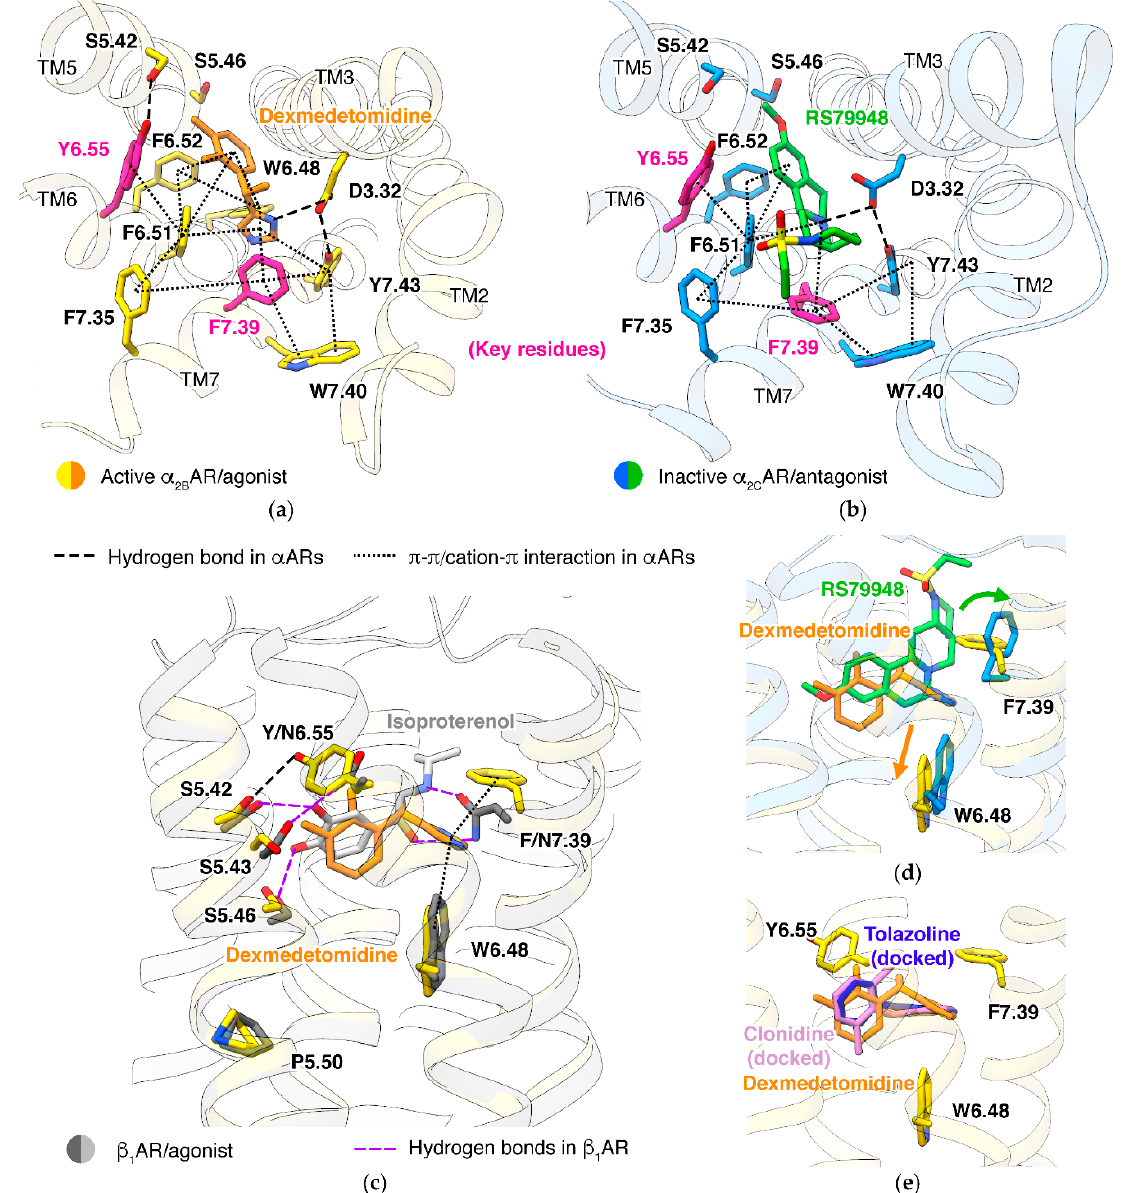
Figure 6. Mechanisms in α 2 adrenergic receptors. ( a ) Agonist recognition (dexmedetomidine in α 2B AR, PDB ID: 6K41 [52] ). ( b ) Antagonist recognition (RS 79948 in α 2C AR, PDB ID: 6KUW [99] ). ( c ) Comparison of agonist recognition in α 2 ARs and β ARs (isoproterenol in β 1 AR, PDB ID: 6H7J [54] ). ( d ) Conformational changes in active/inactive α 2 ARs. ( e ) Binding poses of agonist clonidine and antagonist torazoline, predicted by molecular docking (Glide program in Schrodinger platform 2019-2 [38] ).